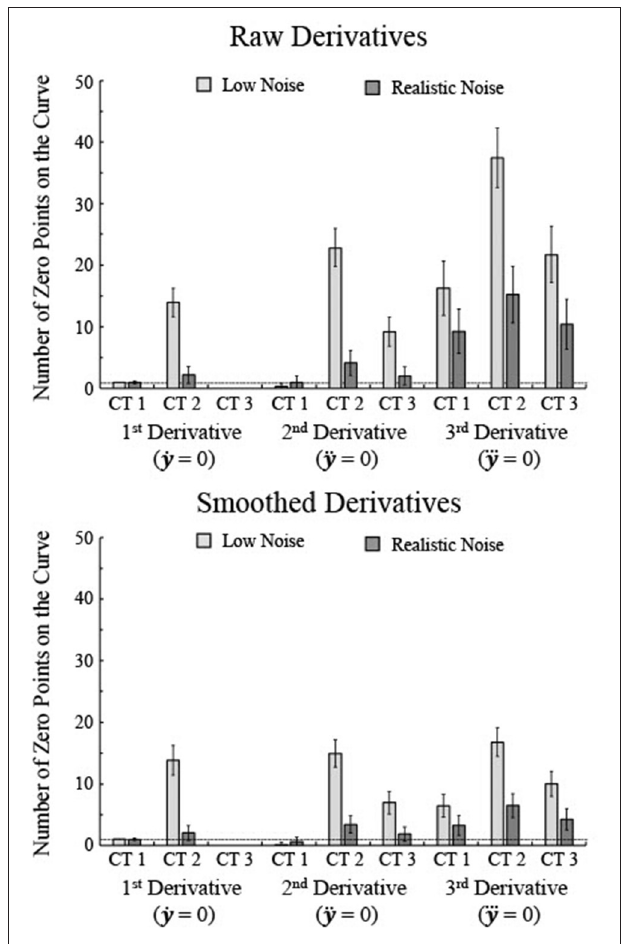
FIGURE 4 | The number of zero points for each of the first three derivatives was determined for 250 simulations each of three types of curves, separately for raw 2nd and 3rd derivatives and smoothed 2nd and 3rd derivatives. Smoothing was done using a sliding window that averaged the five nearest age points. Note that the number of zero points tends to increase as the noise level decreases even though the fits better match the actual maturation rate for lower levels of noise. The horizontal line indicates one zero point. Error bars show one standard